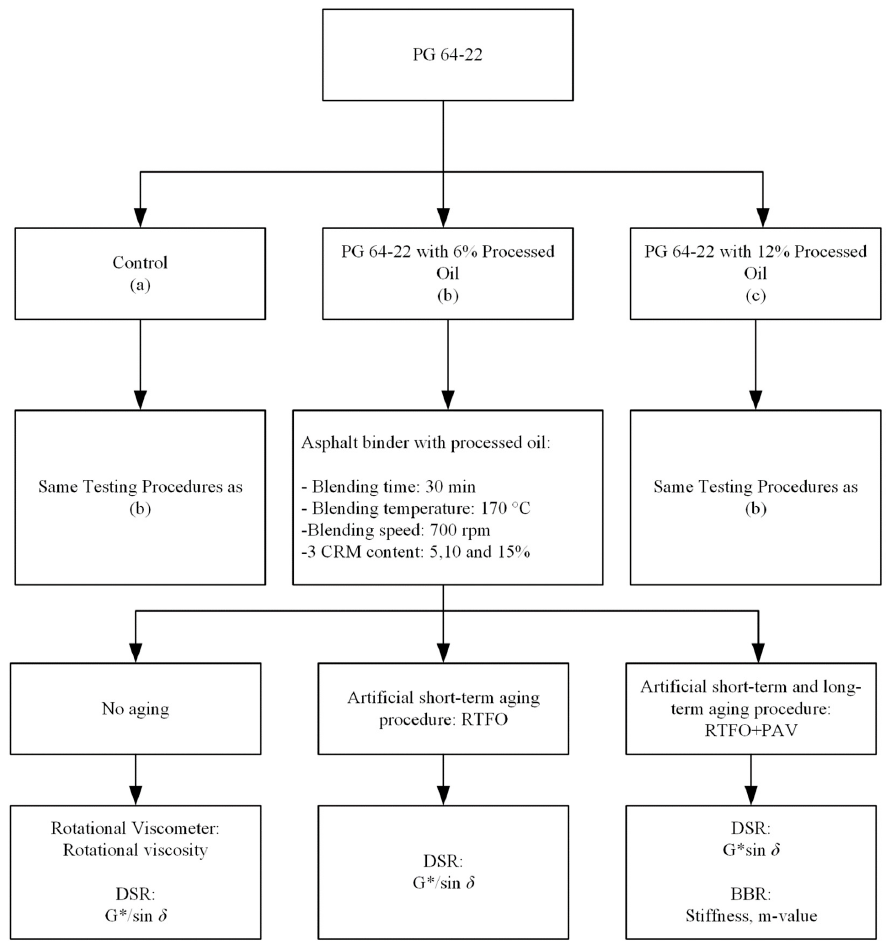
Figure 1. Flow chart of experimental design procedures.